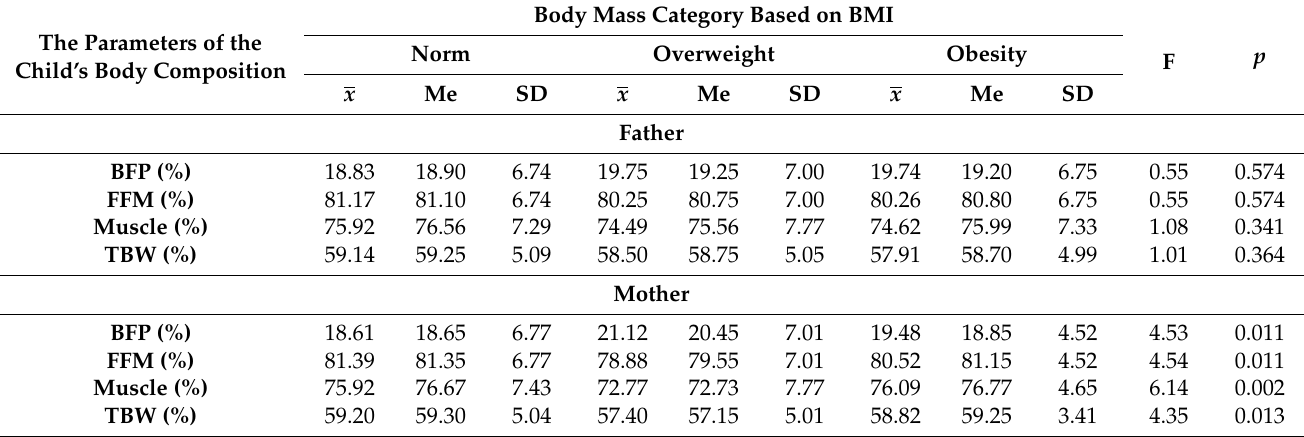
Table 9. The relationship between the parents’ body weight category and the parameters of the child’s body composition.